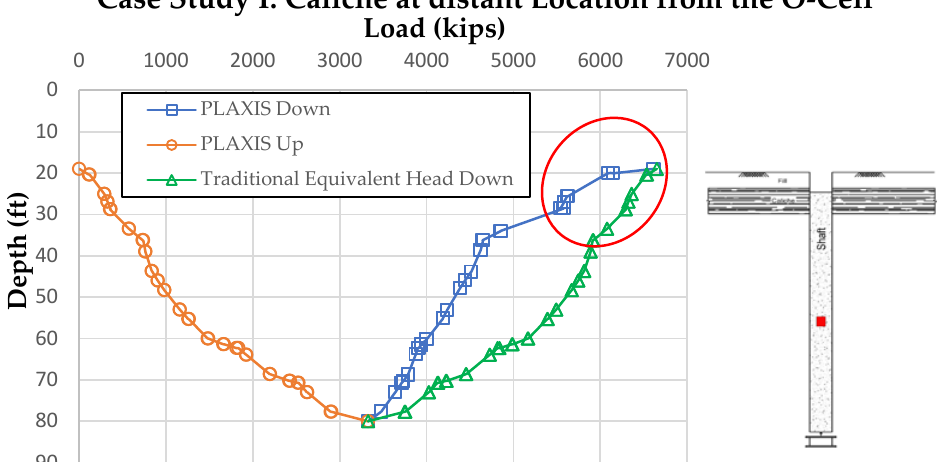
Figure 7. Load transfer distribution of the upward and downward loading by O-cell and top-down load application in the soil profile containing competent caliche layers, based on the finite element simulation of Case Study I.